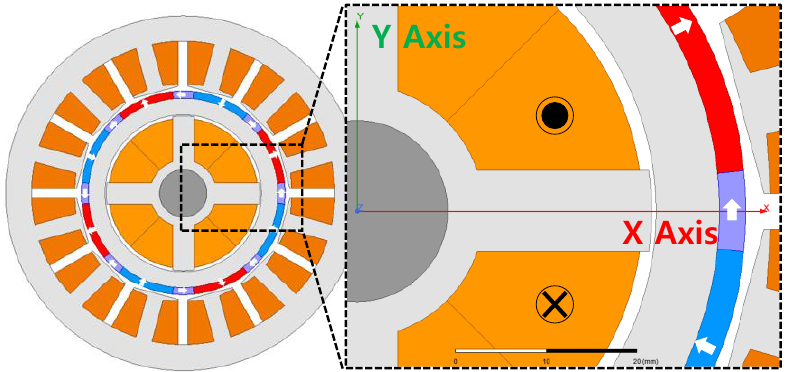
Figure 3. Principle of magnetic bearing.